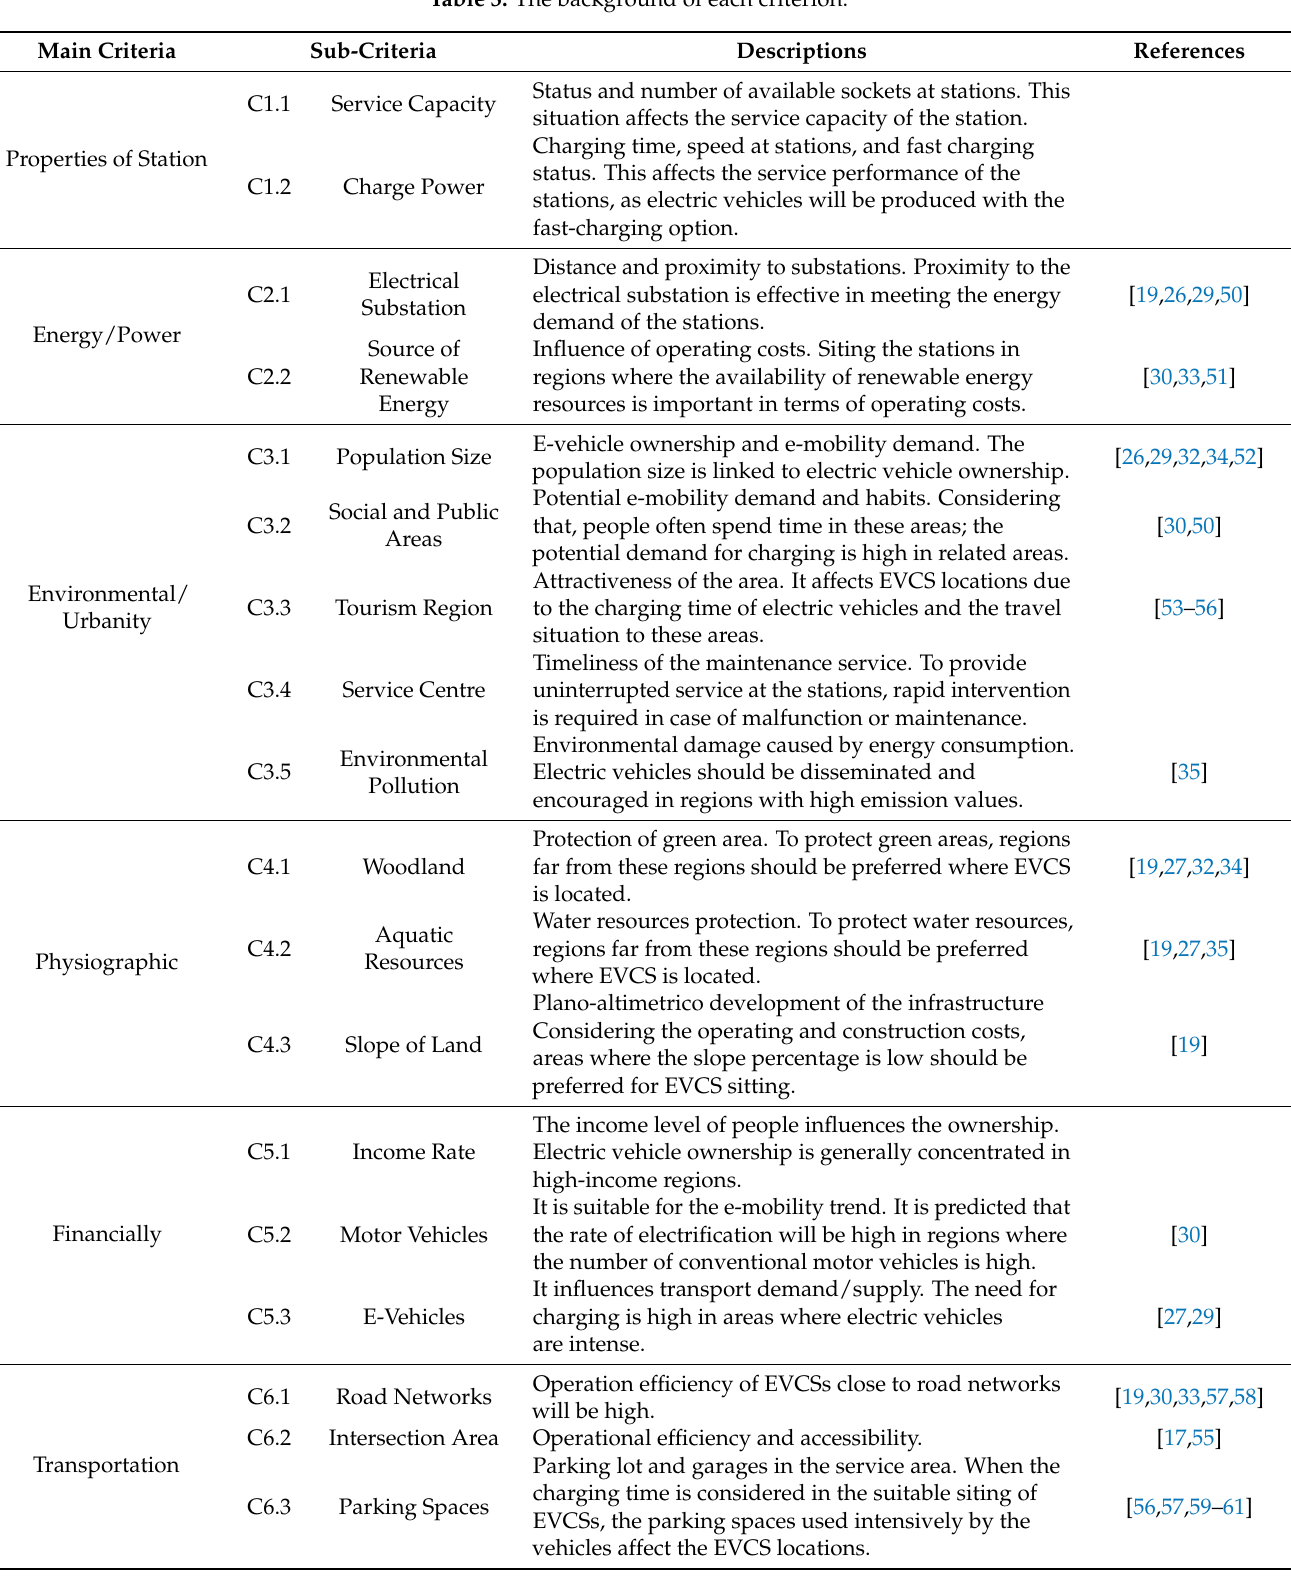
Table 3. The background of each